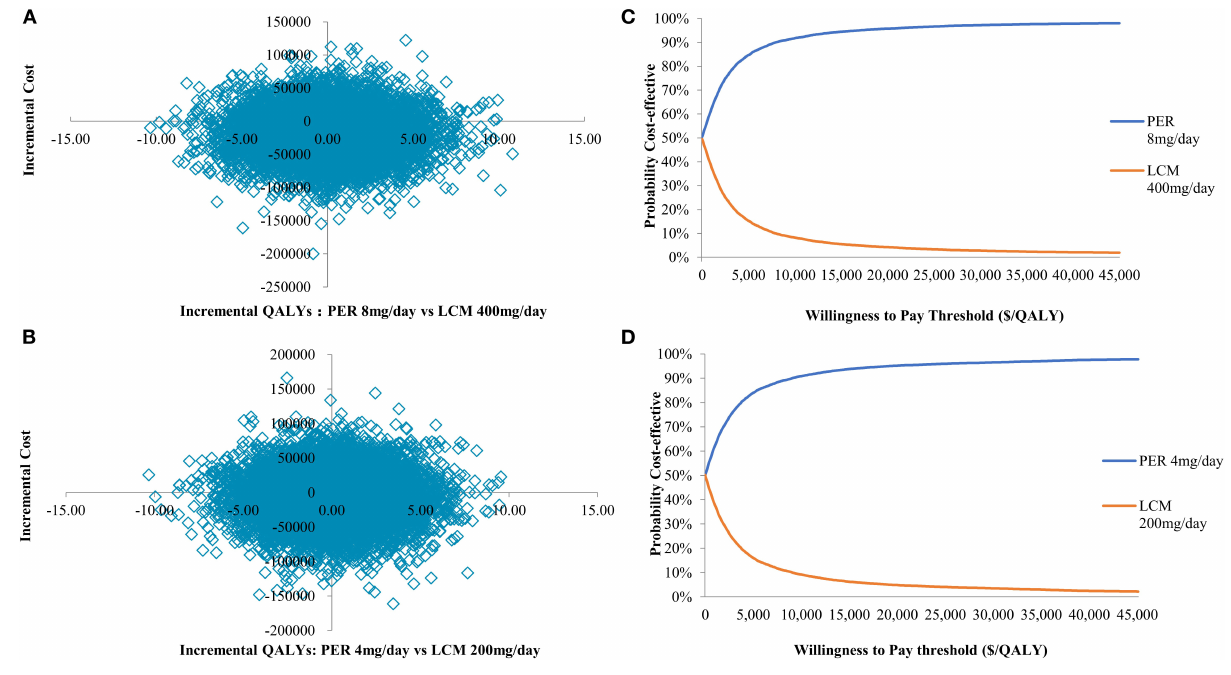
FIGURE 4 | (A,B) Scatterplot of CE plane; (C,D) Cost-effectiveness acceptability curve. PER, perampanel; LCM, lacosamide.